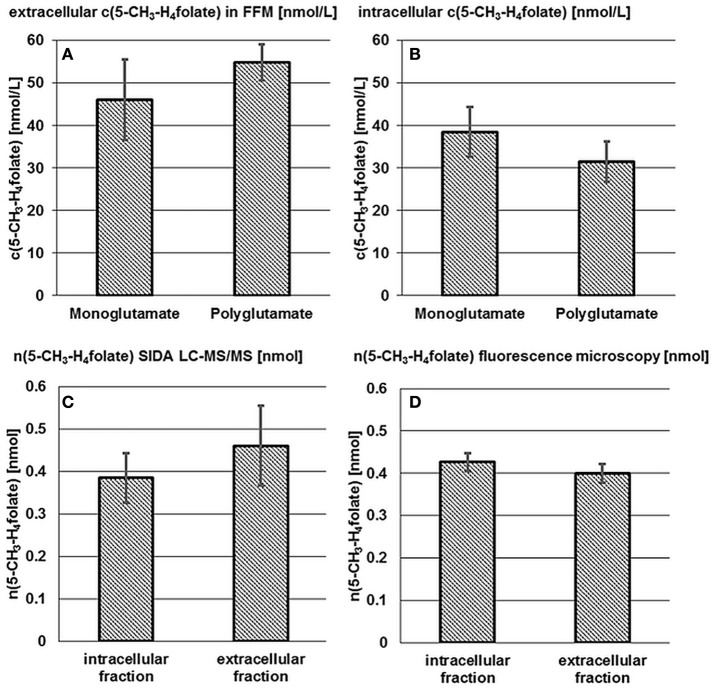
Accumulation and release of 5-CH3-H4folate by B. adolescentis DSM 20083T. Extra- (A) and intracellular (B) 5-CH3-H4folate concentrations in cultures of B. adolescentis DSM 20083T after 24 h in FFM. Absolute amount of 5-CH3-H4folate calculated from SIDA LC-MS/MS (C) and by extrapolation from fluorescence microscopy (D). Data are shown as mean and standard deviations (triplicate experiments).